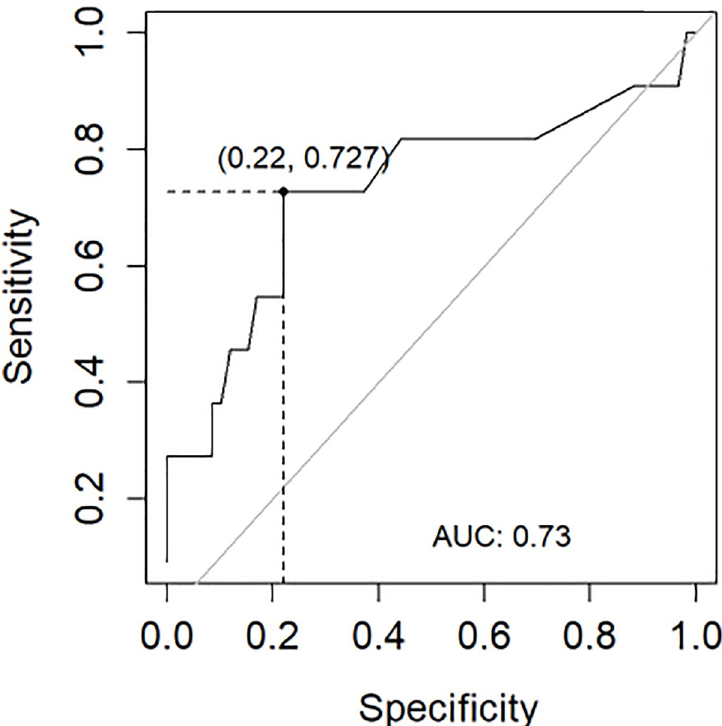
Fig 6. The ROC analysis curve, showing sensitivity and specificity for podocin ELISA